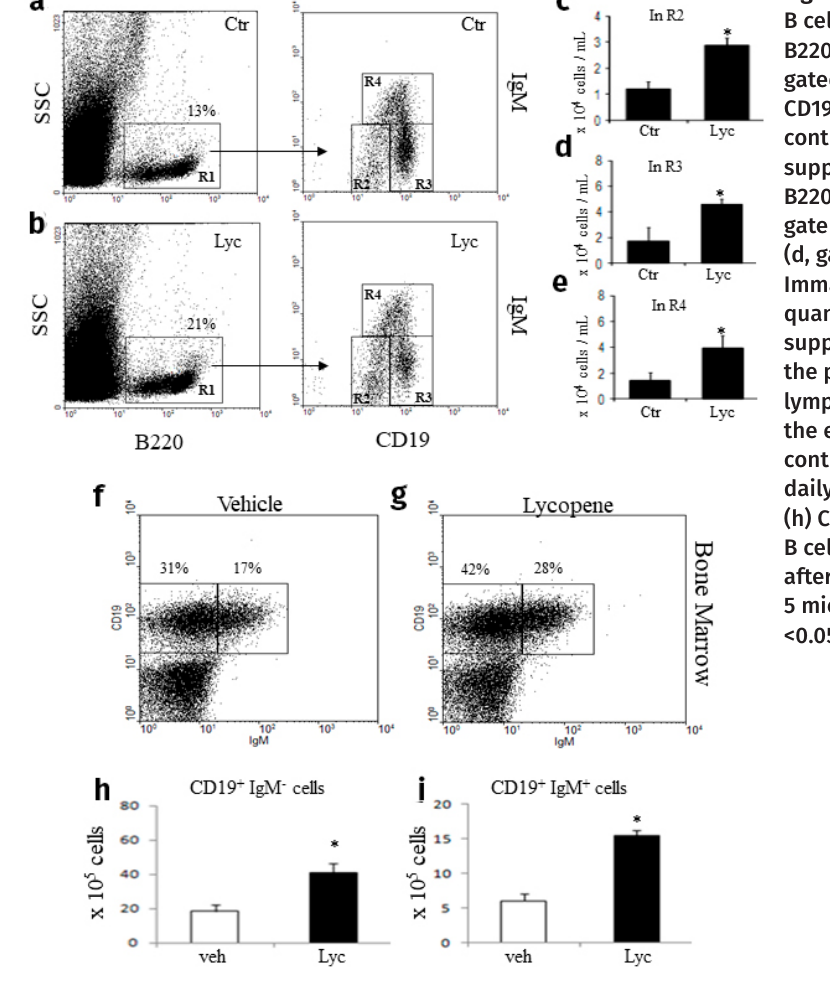
Figure 3. Phenotype of bone